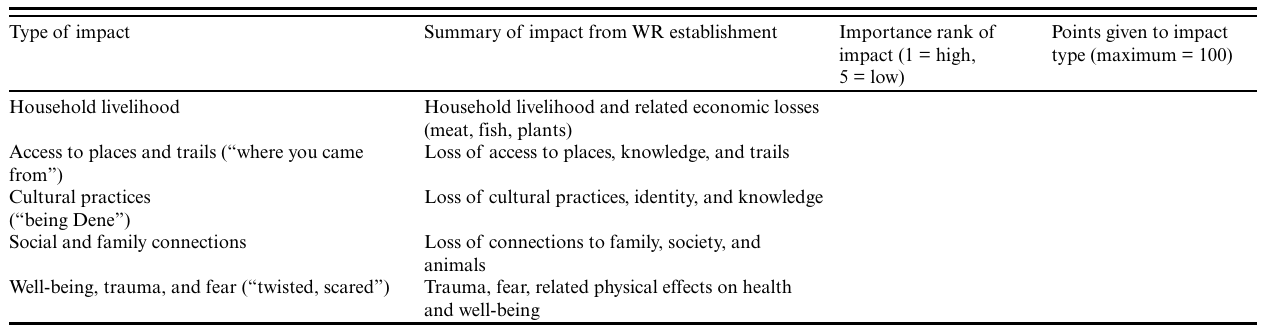
Table 1 . Loss categories used in September 2019 evaluation meetings. WR, military weapons range. The two right-hand columns are left blank because they were to be completed by